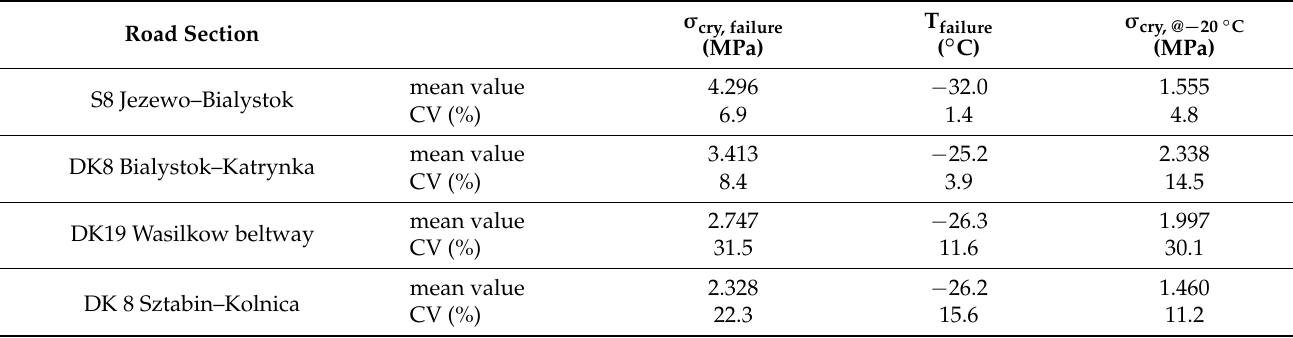
Table 3. Test results of TSRST for the wearing course.